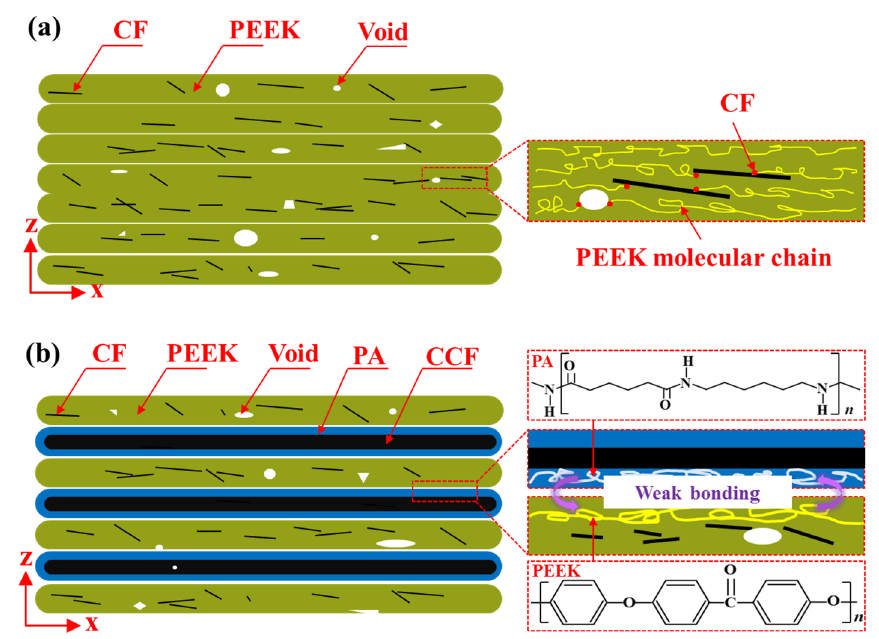
Figure 3. Schematic diagram of FDM 3D-printed fiber-reinforced PEEK composites: ( a ) FDM 3D-printed short-fiber-reinforced PEEK composites; ( b ) FDM 3D-printed continuous-fiber-reinforced PEEK composites.